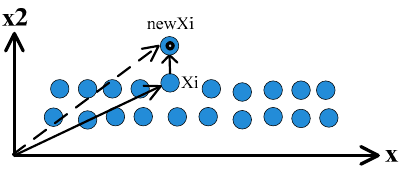
Figure 6. The vibration of elements in an equilibrium position.